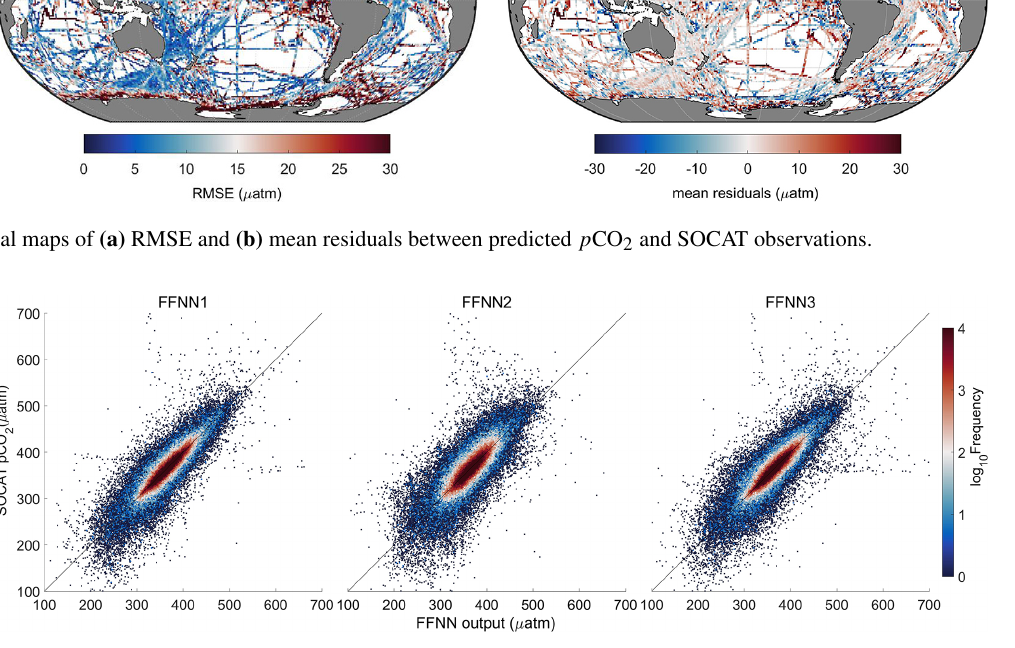
Figure 7. Comparison of FFNN-predicted p CO 2 with SOCAT p CO 2 . FFNN1 was based on predictors selected by the stepwise FFNN algorithm. FFNN2 and FFNN3 were based on predictors from Landschützer et al. (2014) and Denvil-Sommer et al. (2019),